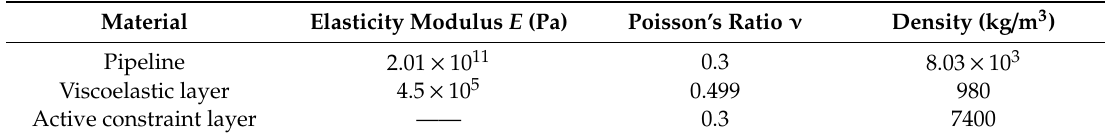
Table 2. Performance parameter of the pipeline with ACLD patches.